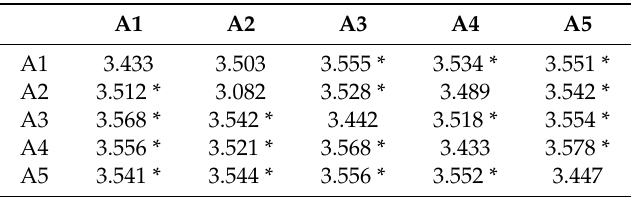
Table 7. The total relation matrix T .